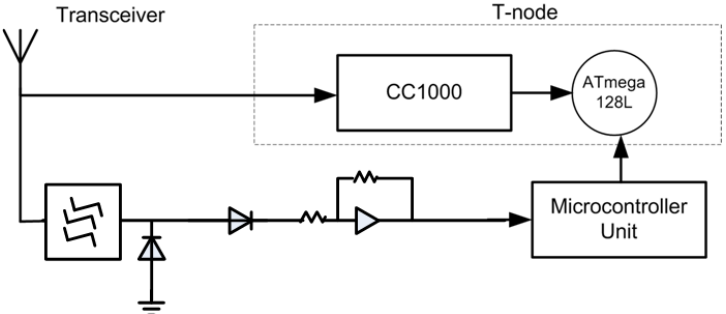
Figure 5. A wake up radio attached to the